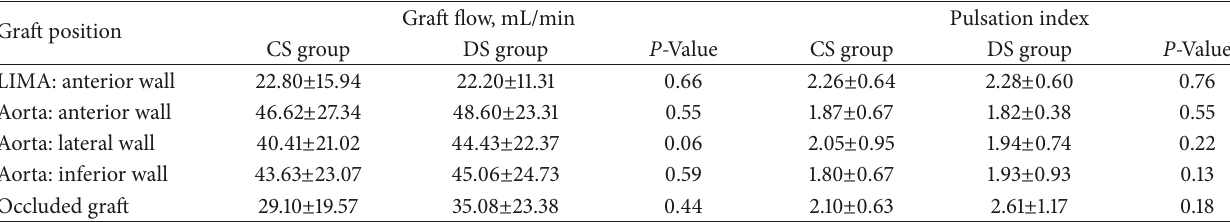
Table 3: Transit-time flow outcomes: mean graft flow and pulsation index in CS and DS groups. Graft flow, mL/min